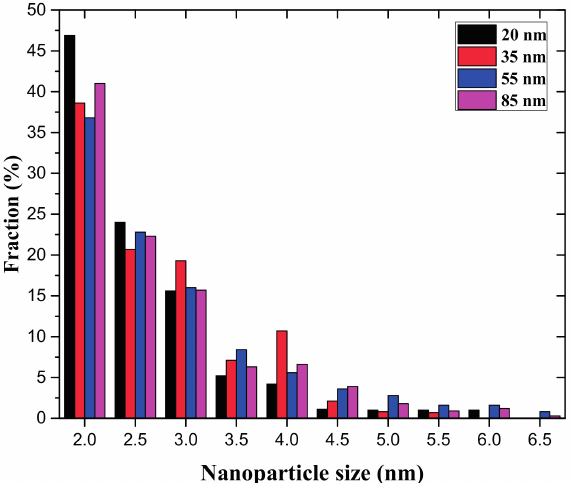
Figure 3. Size distribution of sputtered gold clusters ejected from gold NWs after ion irradiation. The gold NWs with a diameter ranging from 20 to 85 nm were irradiated by 1.4 MeV Xe with the fluence of 1 × 10 14 ions cm − 2